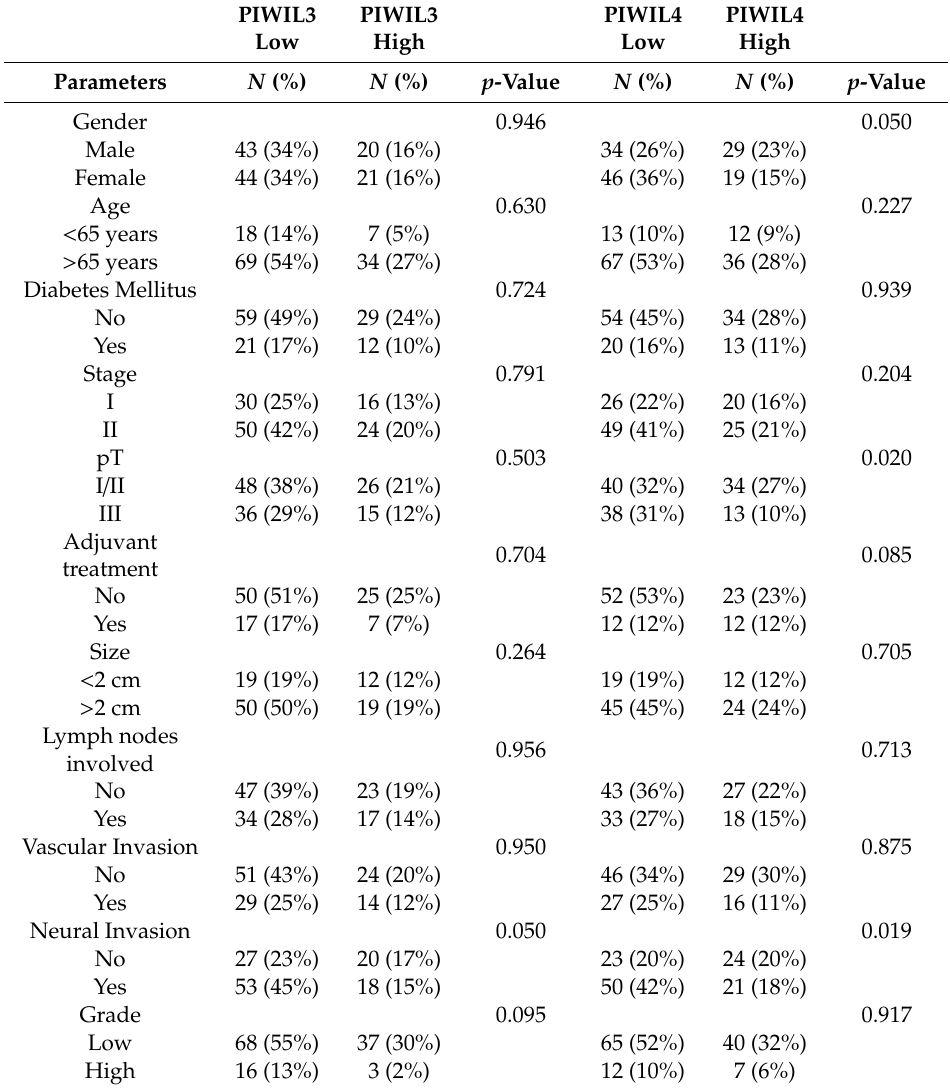
Table 4. Statistical association between PIWIL3 and PIWIL4 protein expression with clinico-pathological